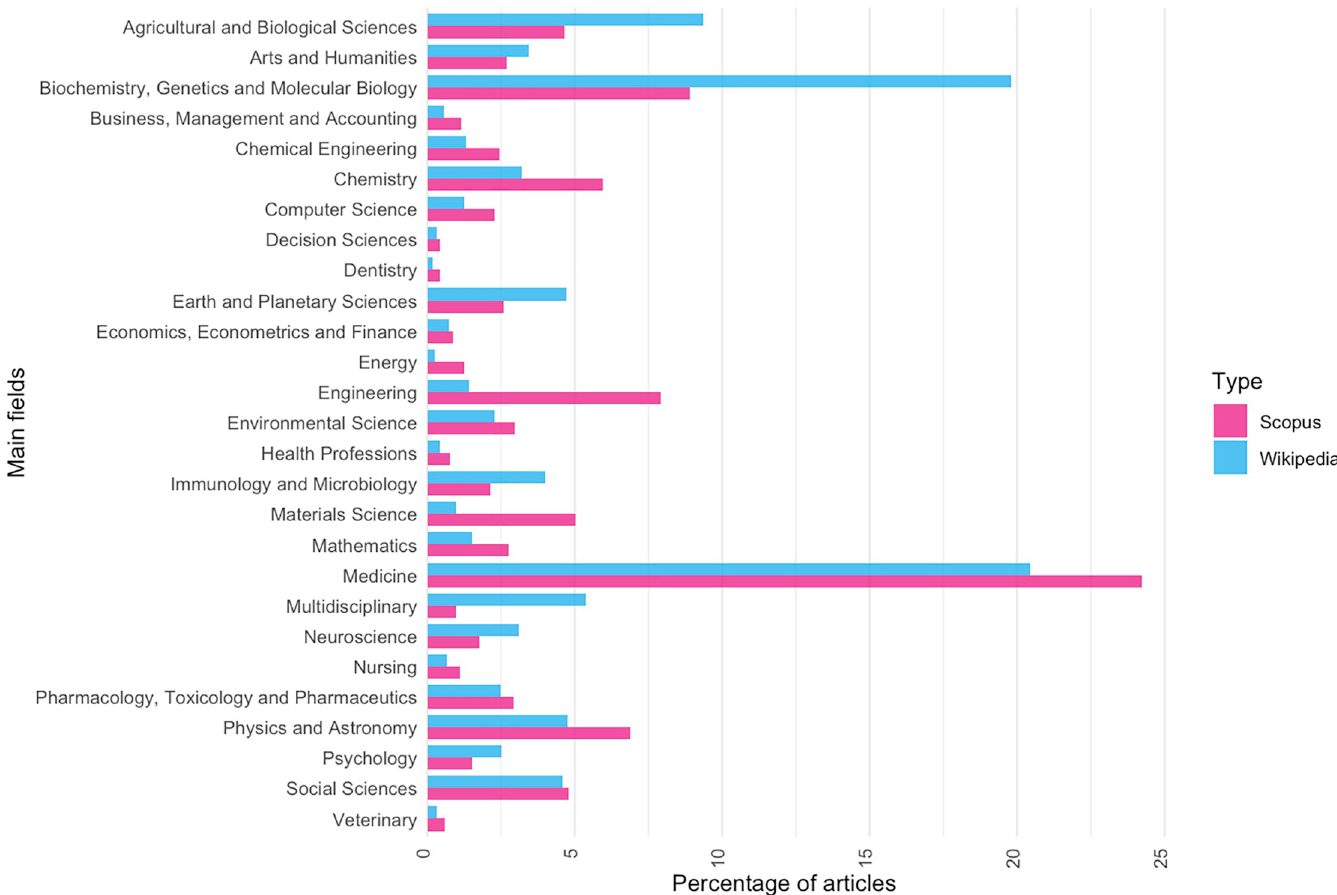
Fig 8. Comparison of the percentage of articles by main field in Scopus and